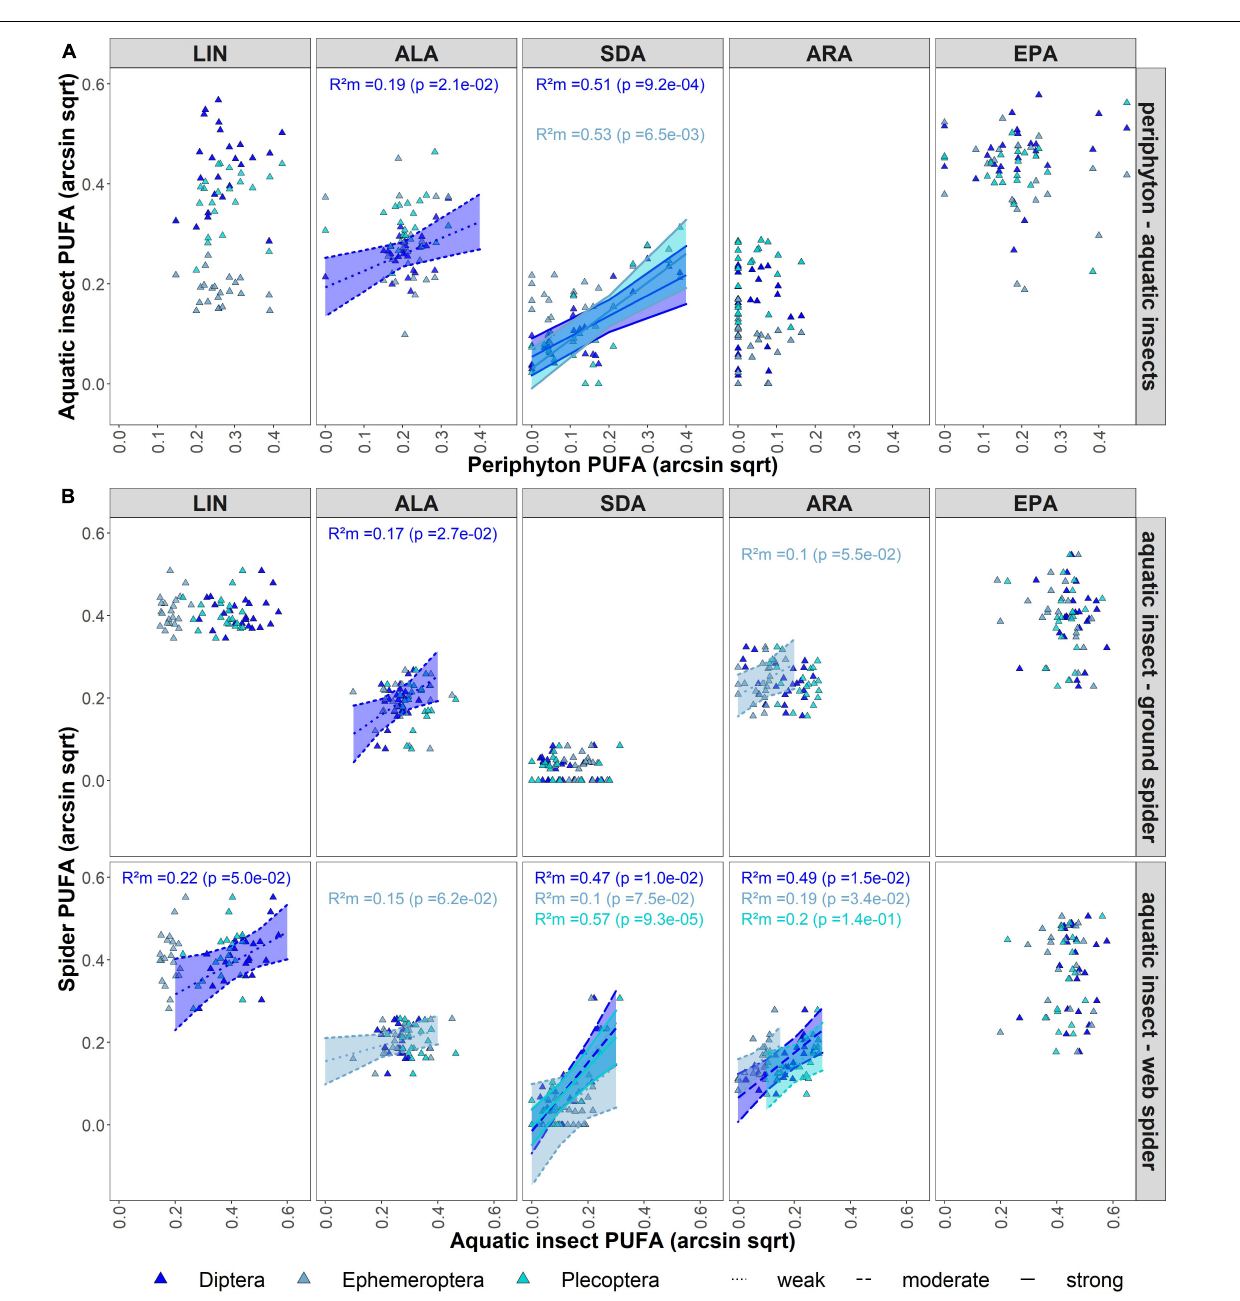
ANOSIM R = 0.87, p = 0.001) but still distinct from terrestrial insect reference samples (ANOSIM R = 0.72, p =